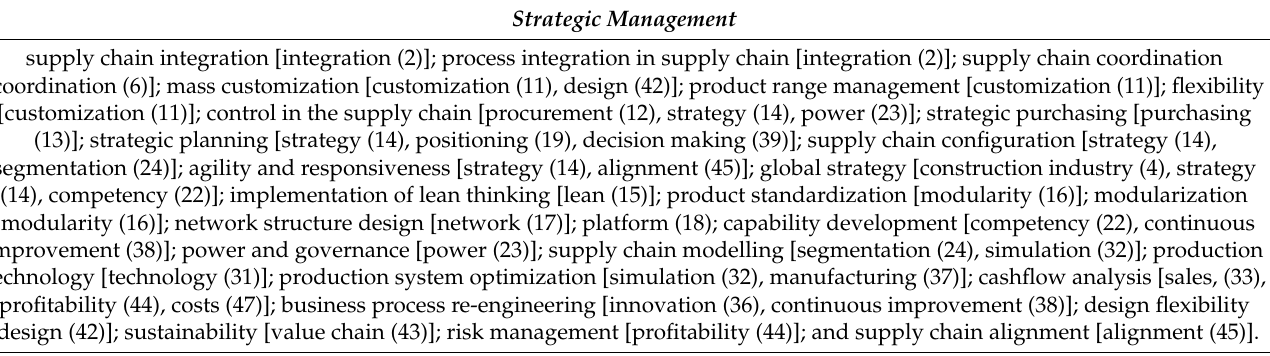
Table 3. PHB-SCM themes [keywords